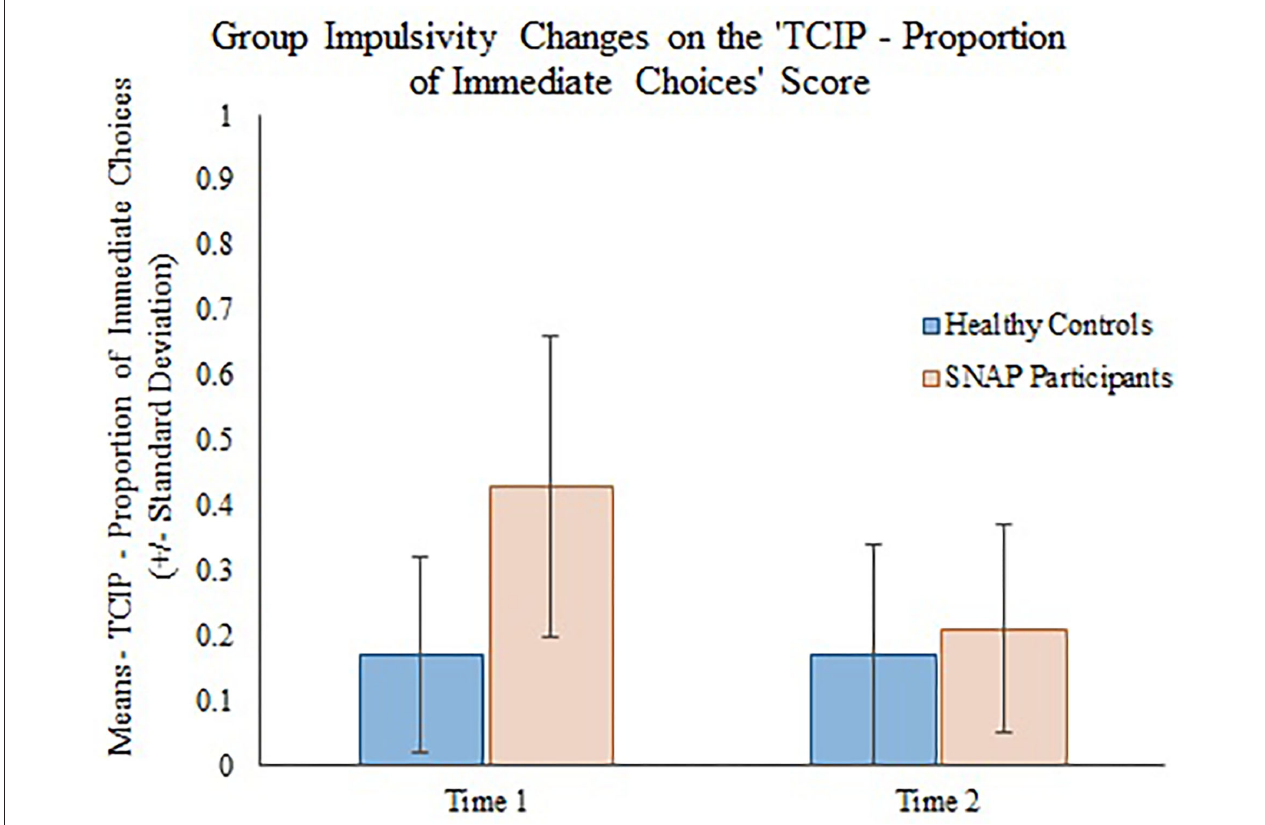
FIGURE 2 | Group impulsivity changes on the Two Choice Impulsivity Paradigm–Proportion of Immediate Choices